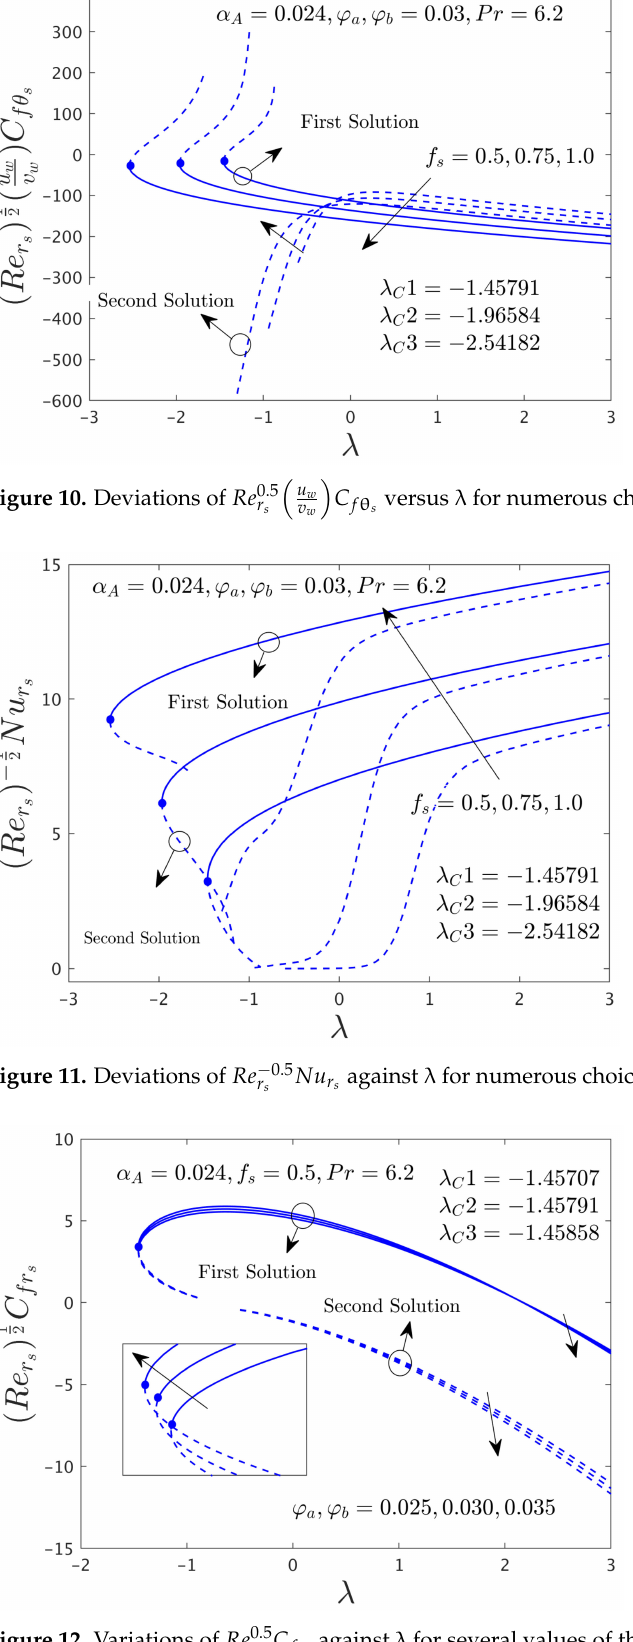
Figure 12. Variations of Re 0.5 r